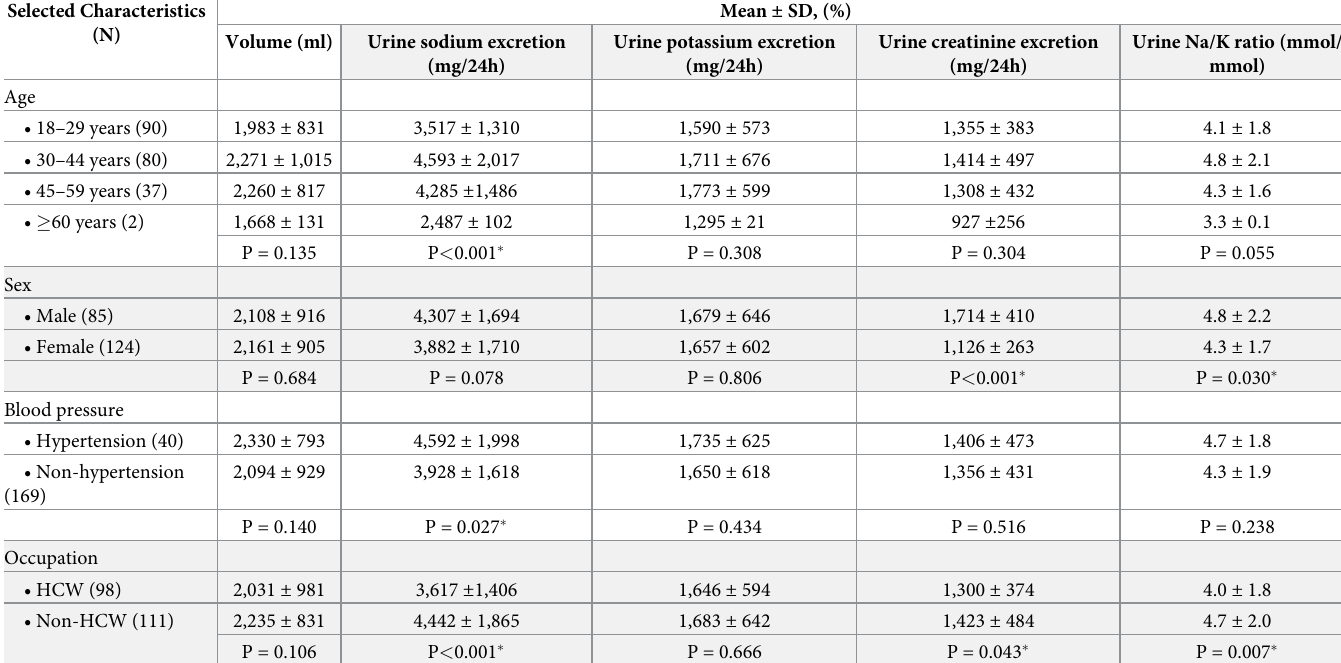
Table 2. Urine excretion in subgroup population (N = 209). Selected Characteristics